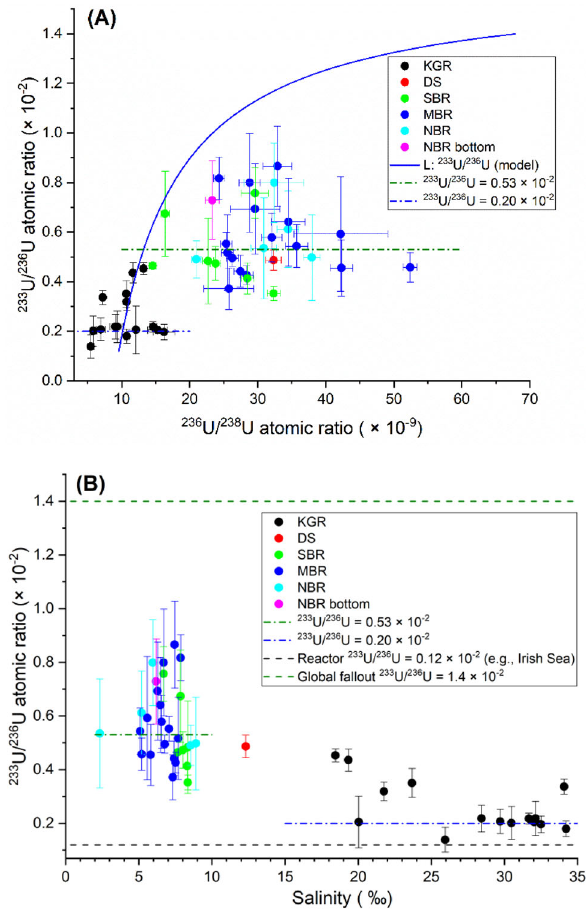
Fig. 5 Results of 233 U/ 236 U. 233 U/ 236 U atomic ratio vs. 236 U/ 238 U atomic ratio ( A ) and salinity ( B ). KGR Kattegat – Skagerrak region including the Kattegat, Skagerrak and Danish west coast nearby the North Sea, DS Danish Straits including the Belt Seas and the Sound, SBR South Baltic Sea region including Arkona Basin, Borholm Basin, and South Baltic Proper, MBR Middle Baltic Sea region including Northern Baltic Proper, Western Gotland Basin, Eastern Gotland Basin and Gulf of Riga, NBR North Baltic Sea region including Archipelago and Åland Sea, Bothnian Sea, and Bothnian Bay, L (blue solid line) the best- fi t binary mixing line between the North Sea water and a freshwater end member with salinity = 0, 238 U = 0.4 µ g/l, 236 U/ 238 U atomic ratio = (6.79±0.75) × 10 − 8 , and 236 U = (6.87± 0.76)× 10 7 atom/l. Uncertainties are expanded uncertainties using a coverage factor of k =